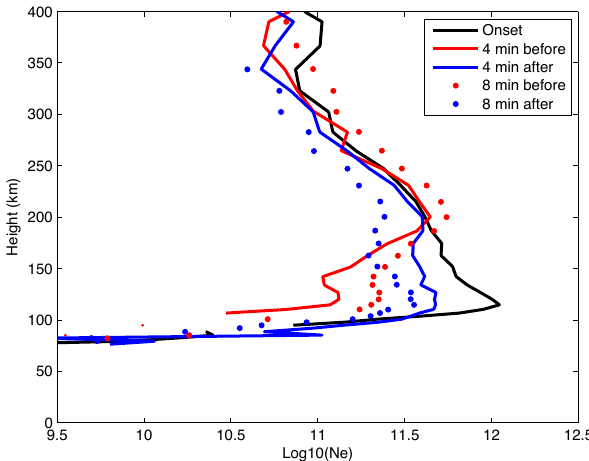
Fig. 9. Ionospheric electron density profiles as recorded by the EIS- CAT Tromsø radar during the early part of the expansion phase of substorm 2. The solid black line is the electron density at the time when the precipitation reaches the radar beam at 16:48UT. The red line is the electron density 4min earlier, and red dots 8min earlier. Blue line is the electron density profile 4min after and blue dots 8min after,